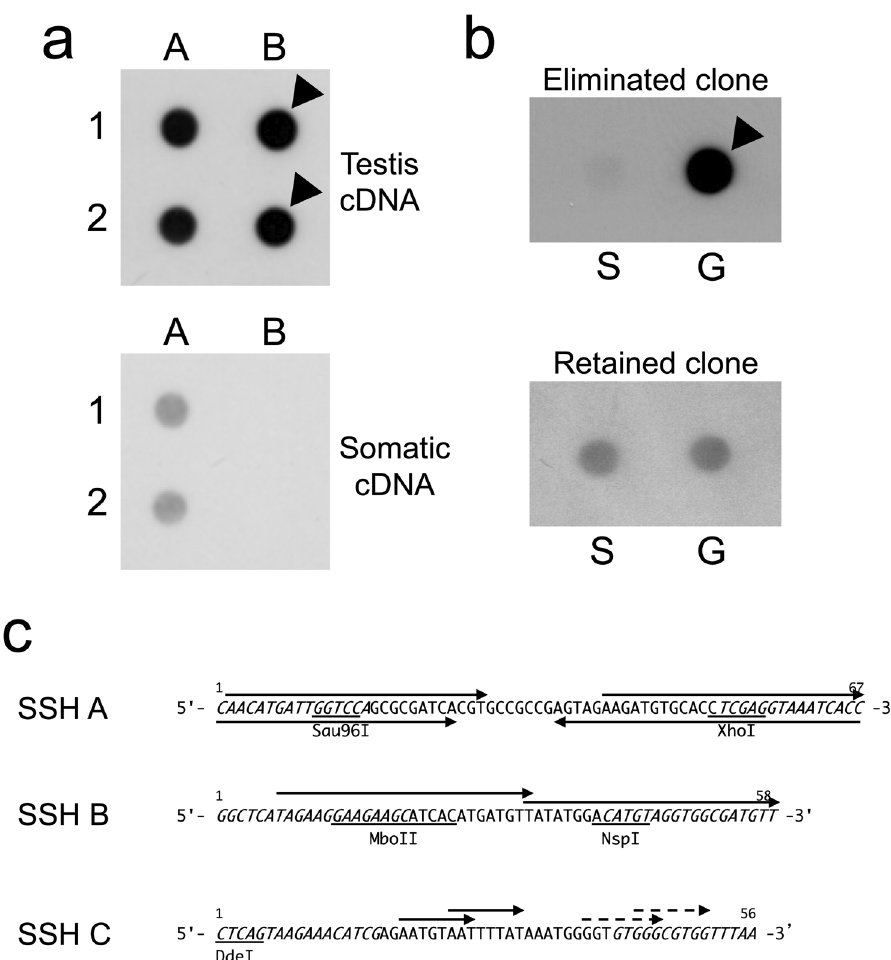
Figure 2. Representative dot-blots from the screening of cDNA clone and consensus sequences of three germline-specific repetitive DNA families. ( a ) Two identical membranes were dot-blotted with four cDNA clones and hybridized with probes prepared from Rsa I-digested testis cDNA (top) and Rsa I-digested somatic cDNA (bottom). The differentially expressed clones are indicated by arrowheads. ( b ) Membranes were blotted with somatic (S) and germline (G) genomic DNA and hybridized with probes prepared from each clone. The testis genome-specific signal is indicated by an arrowhead. ( c ) Each consensus nucleotide sequence was deduced from the inserts of germline genomic DNA clones. Upper arrows: the direct repeats. Lower arrows: the inverted repeats. The other notations correspond to those in Fig. 1. The sequence data obtained here have been deposited in GenBank